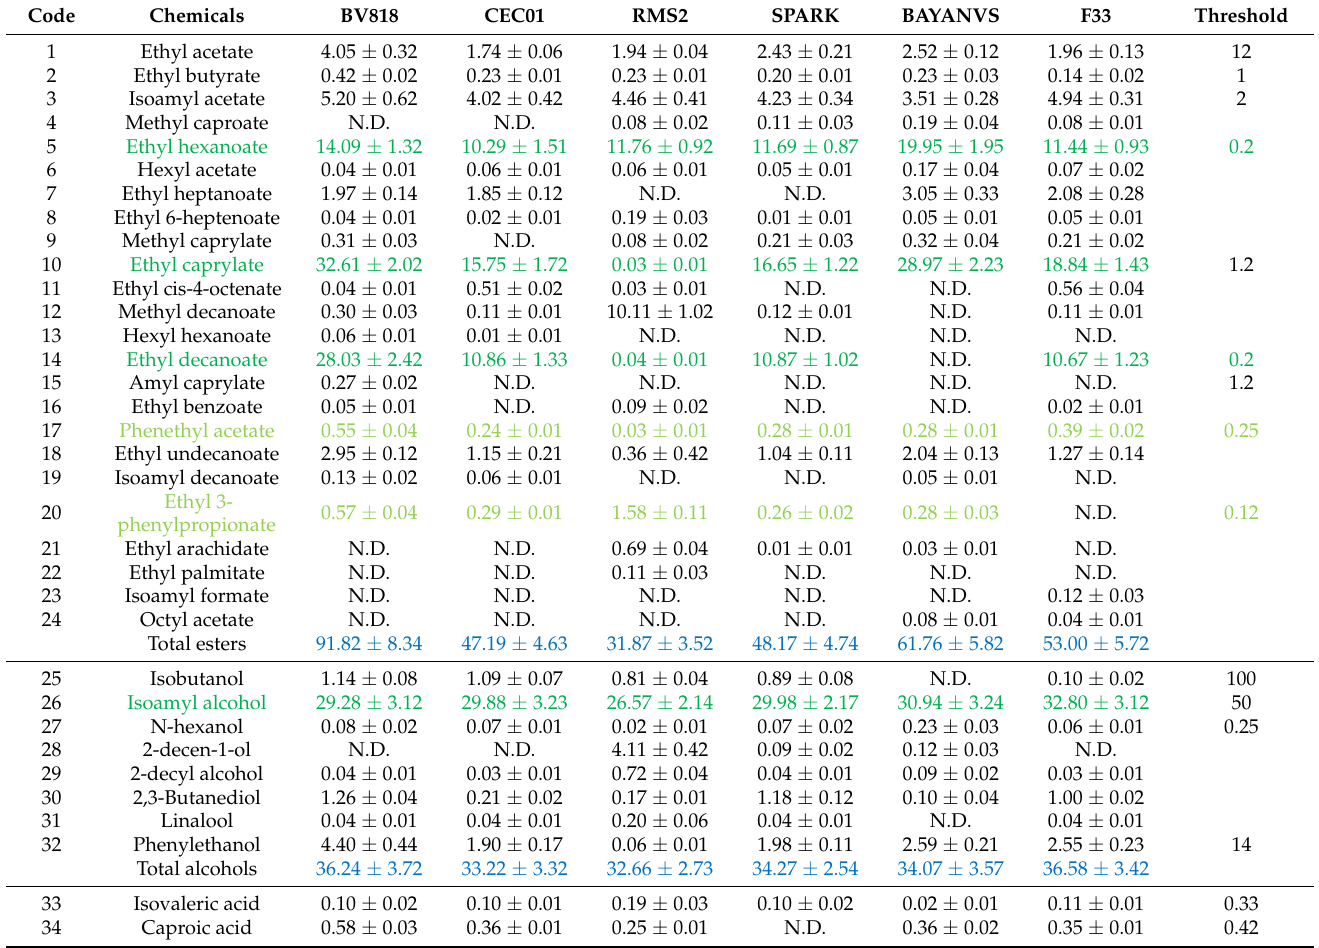
Table 1. The contents of aroma-active compounds of the jujube wine fermented by the six different winemaking yeasts. Code